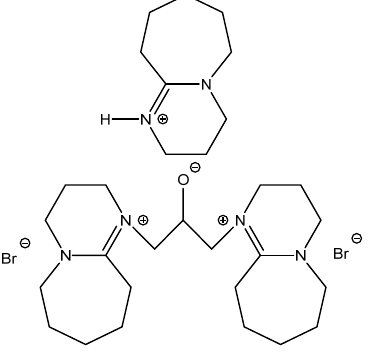
Figure 13. Structure of most effective OH-functionalized DBU-based IL [95].